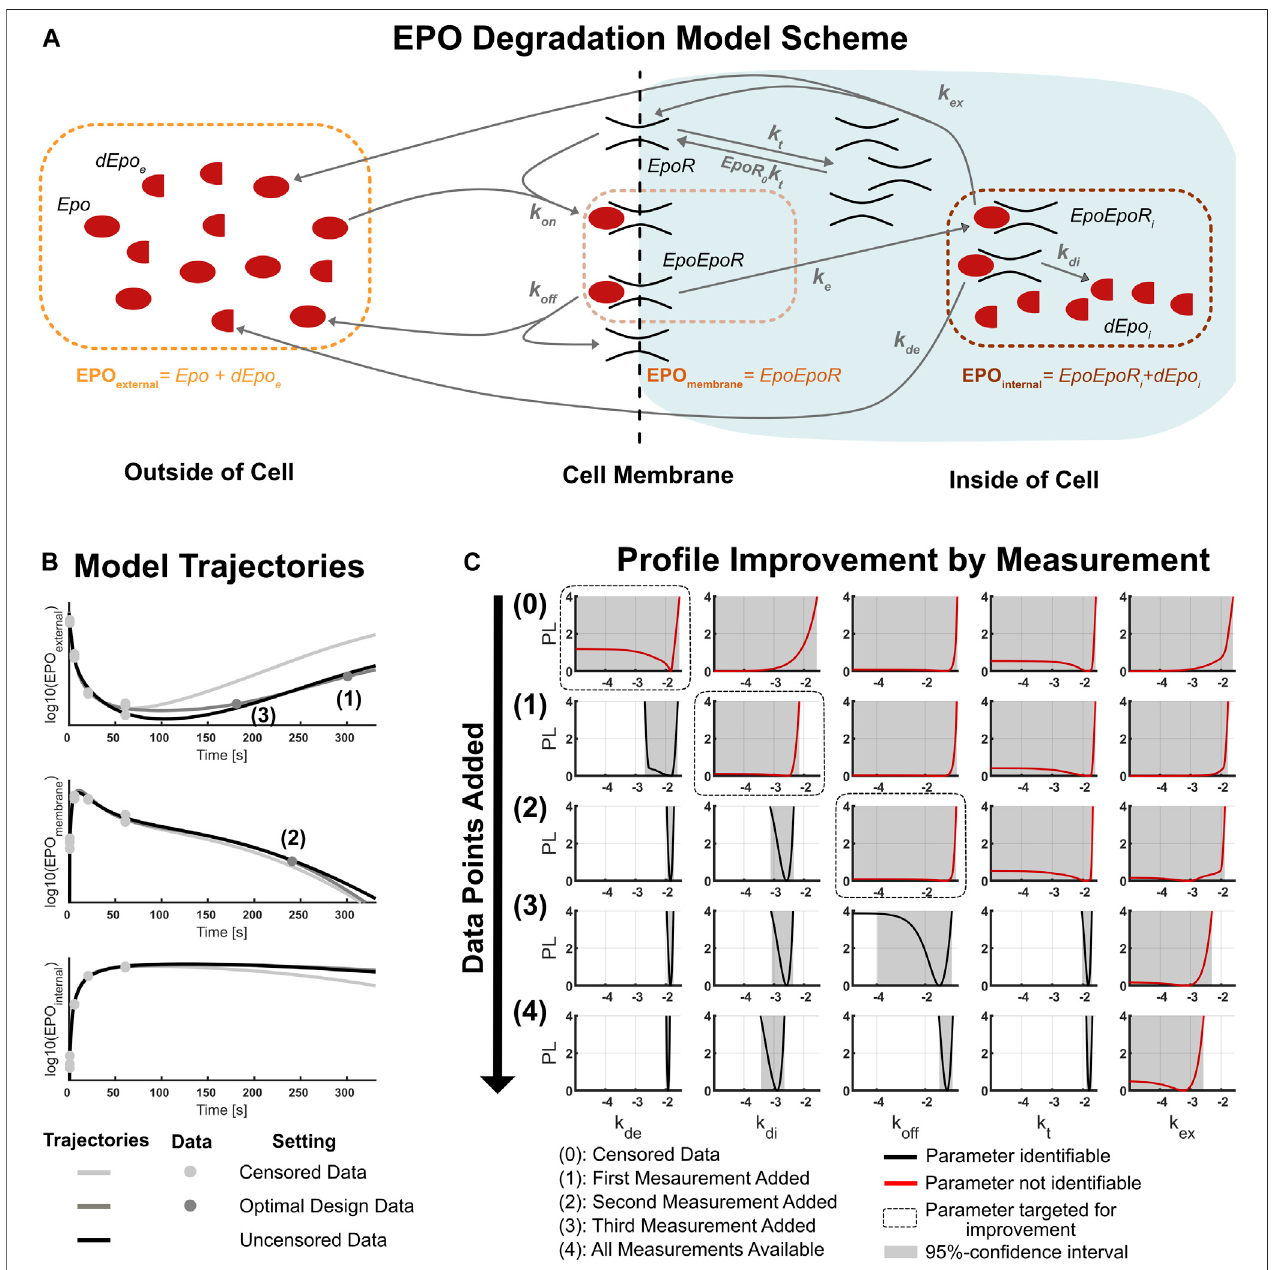
FIGURE 4 | (A) : Scheme of the biological dynamics in the EPO degradation model (Becker et al., 2010). There are six model states (black text) which interact through different biological reactions (gray arrows) and three observables (colored text). EPO is transported into the cell and degraded there. (B) : Model trajectories for the observables oftheEPO-model.Theplottedcurvesarethe best fi ttrajectoriesfor threedifferent datasets:thecensored dataset used atthestartoftheexperimental design analysis, the data set after adding three sequentially proposed data points, and the uncensored published data set. The numbers indicate the order of the sequentially measured data points. (C) : Change of parameter likelihood pro fi les during the sequential experimental design procedure. The targeted parameter always becameidenti fi able after datafor theoptimal experimental condition proposedby thetwo-dimensionallikelihood approachwasadded intothe model. Incorporatingthe three optimal data points into the model already produces results of similar accuracy compared to the published data set with 36 additional data points.